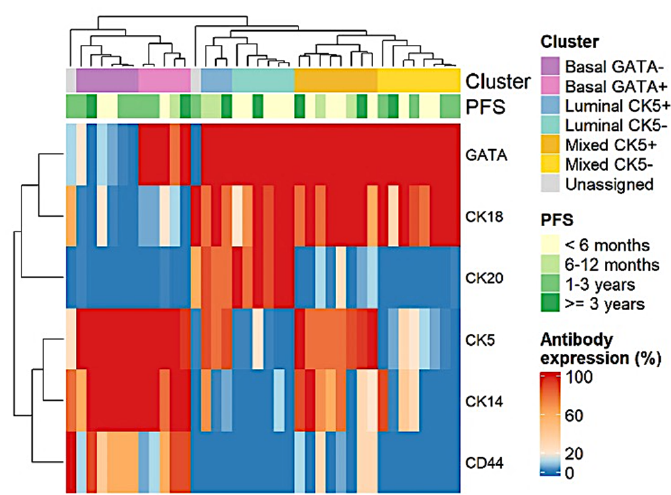
Figure 3. Heatmap of antibody expression (%). Hierarchical clustering with bootstrapping identified 6 clusters, which were labeled luminal, basal or mixed according to the expression of the markers CK20 and CK18. Luminal clusters expressed both markers, mixed clusters expressed only CK18, while basal clusters lacked both markers. Clusters were then further subdivided and labeled according to the expression of CK5 or GATA.